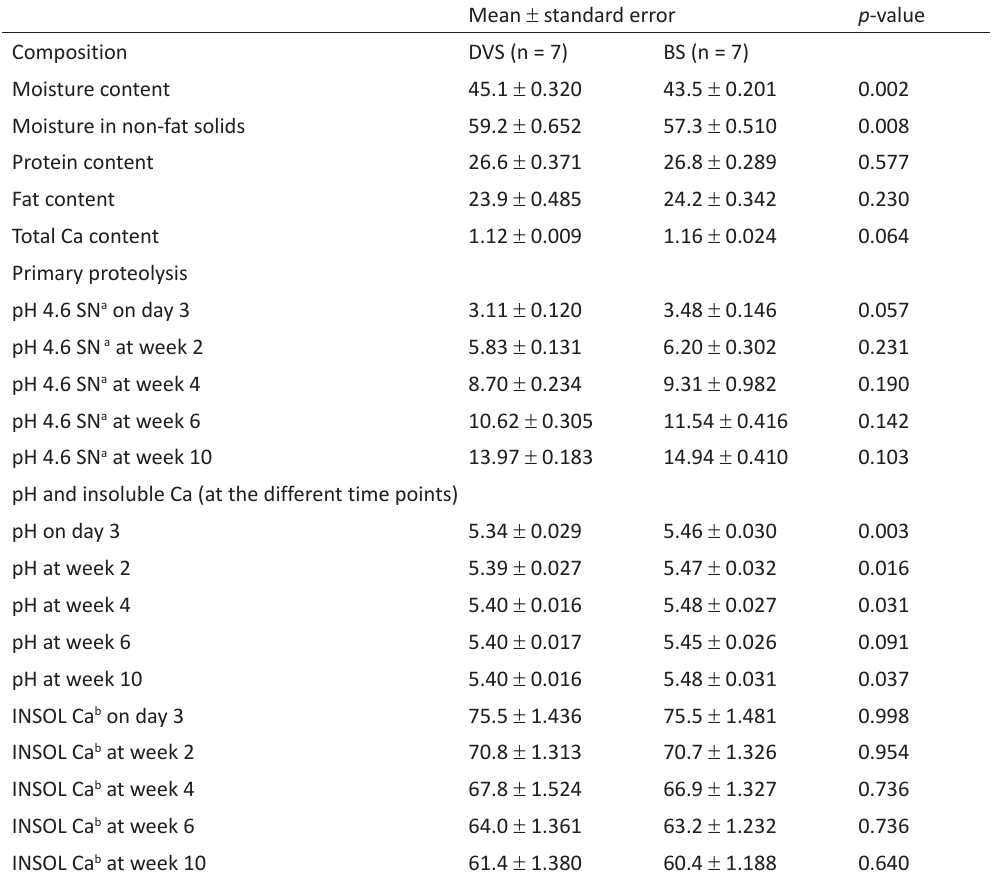
Table 1. Composition (%) of cheeses; p -values express the statistical significance of difference between direct vat set (DVS) and bulk set (BS) cultured cheeses according to the pairwise